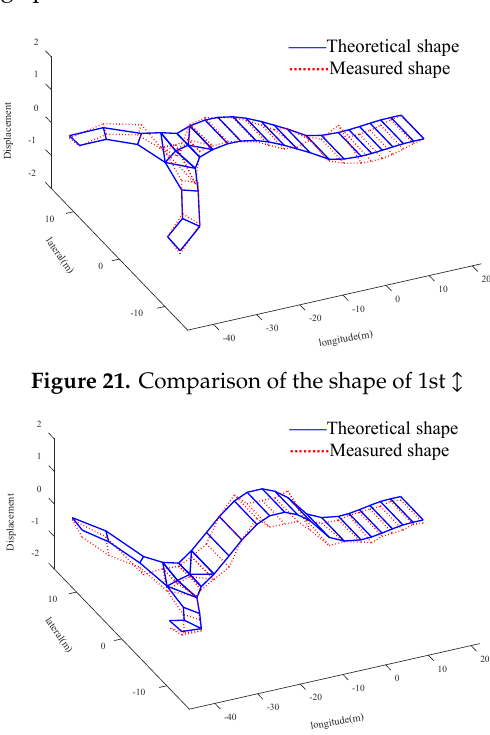
Figure 22. Comparison of the shape of 2nd .